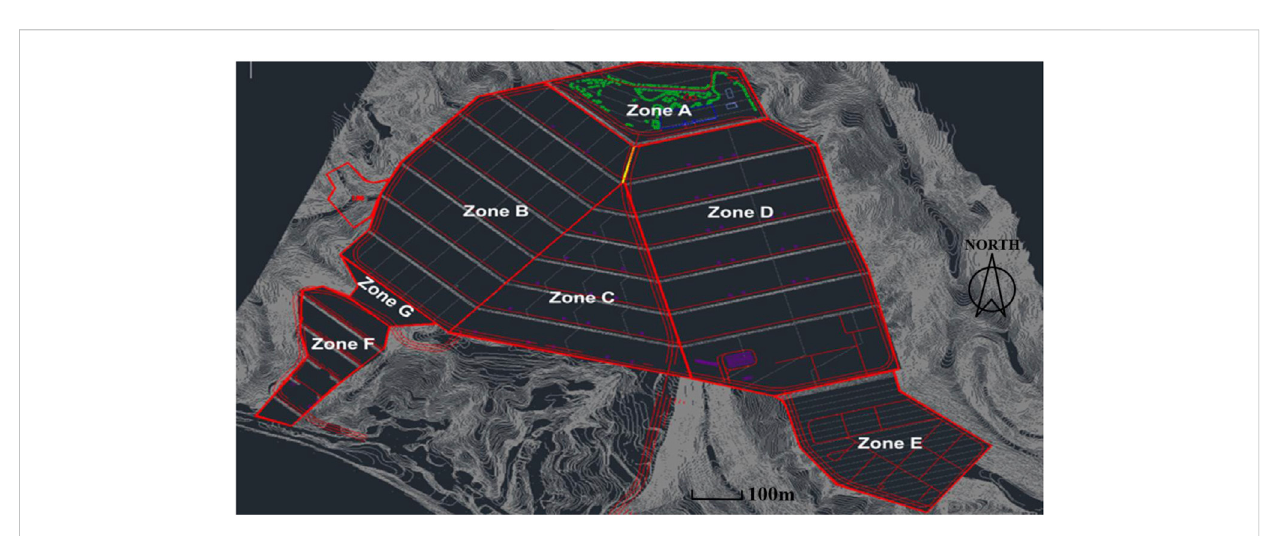
FIGURE 2 Plan design drawing of the Alleviation Industrial